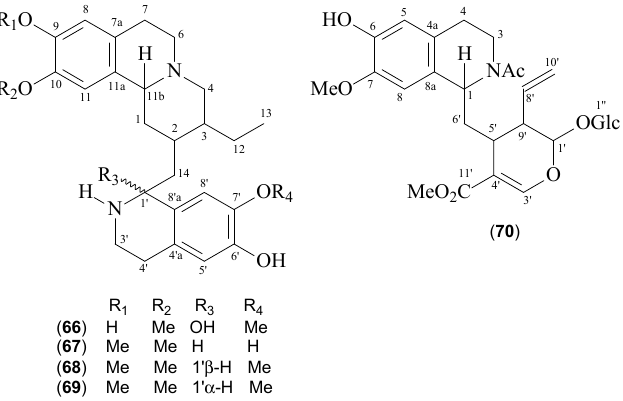
Figure 4. Structures of Benzoquinolizidine Alkaloids from P. klugii. Table 6. 13 C-NMR Data of Benzoquinolizidine Alkaloids from P. klugii .